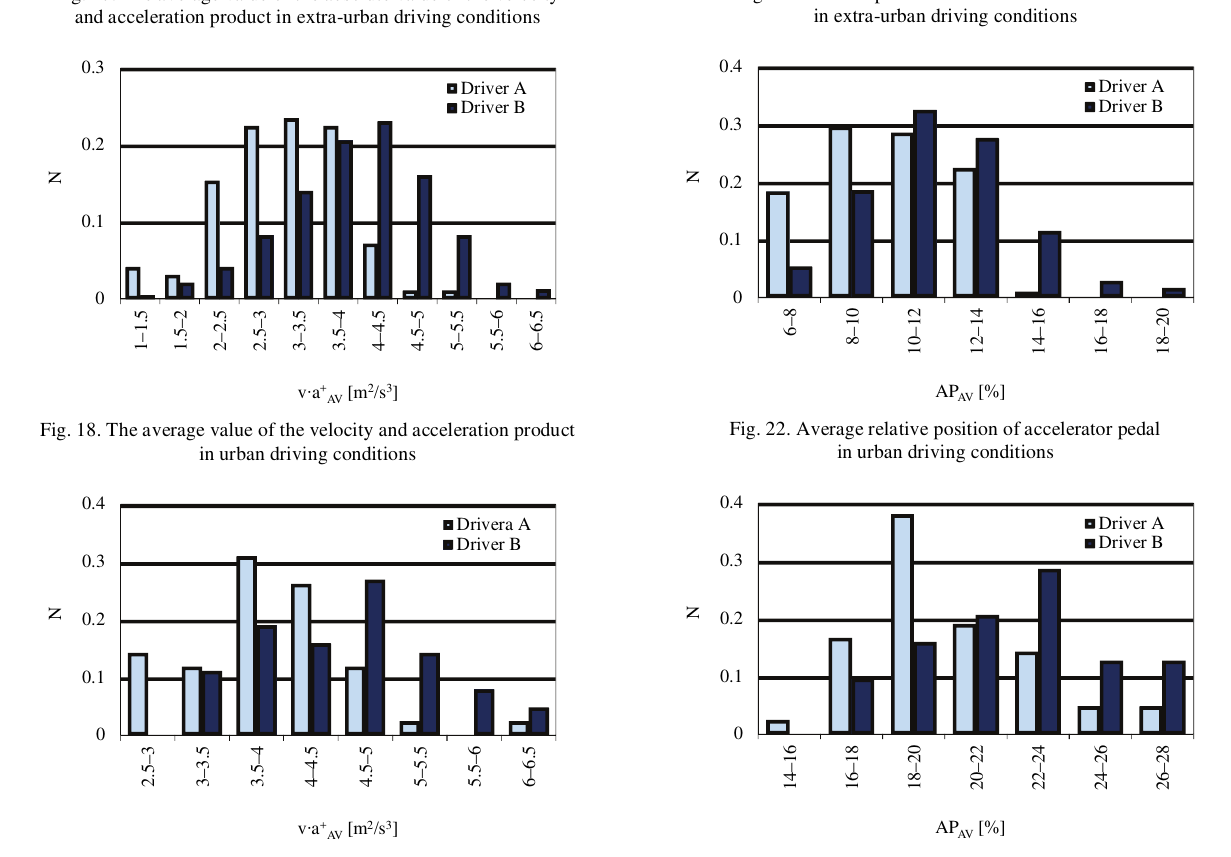
Fig. 23. Average relative position of accelerator pedal in extra-urban driving